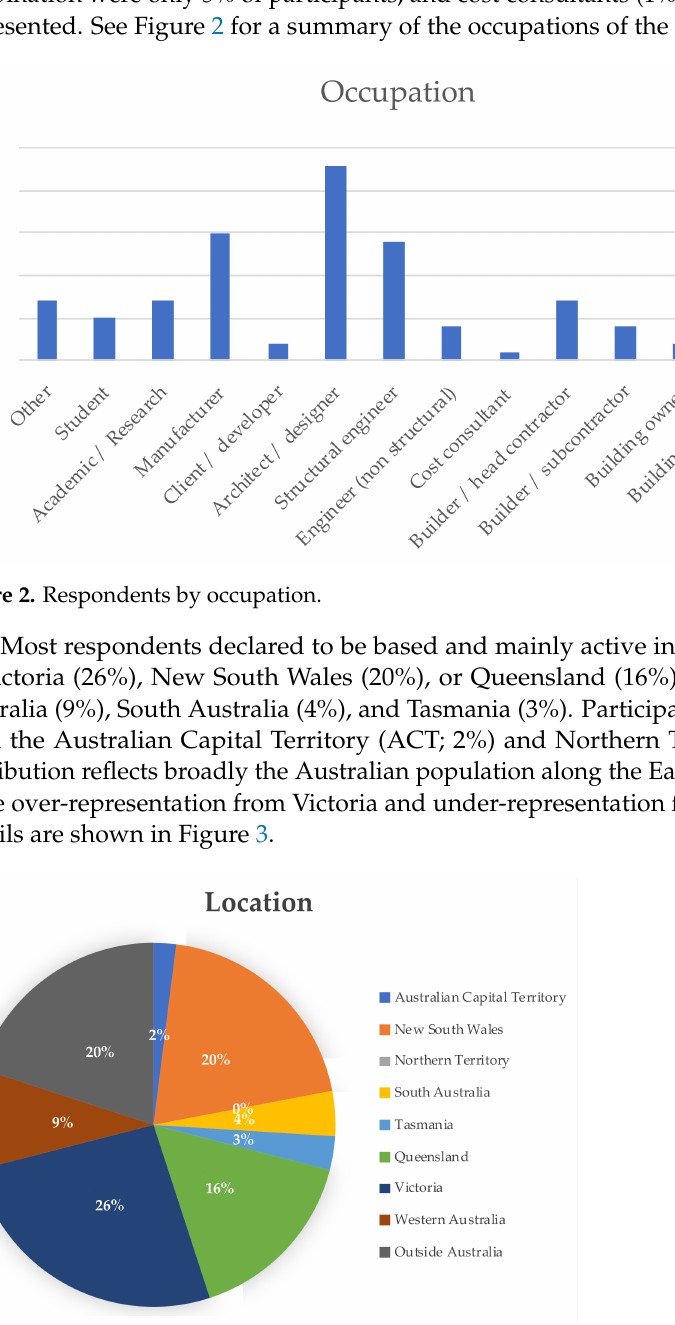
Figure 3. Location of survey respondents. A significant number of respondents (20%) of the survey were based overseas. The specified locations of these participants were distributed worldwide (Europe, Africa, North America, South America, and South-East Asia) with New Zealand, United States of Amer- ica, and United Kingdom being the most represented countries (Figure 4). The distribution of occupation among international respondents reflects the distribution of the full sample, with a prevalence of architects, engineers, and manufacturers. The high level of inter- national participation in the survey confirms that the Australian market of engineered timber is inter-connected on a global scale. Judging from some open-ended responses, it is plausible to assume that some of these respondents have ongoing, or at least past, business ties with